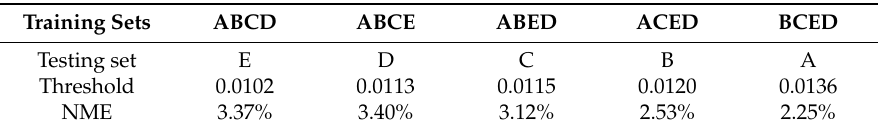
Table 4. Model validation using five-fold